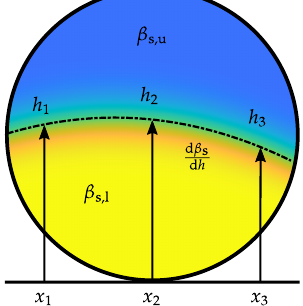
Figure 5. Parametrization of flow patterns [26].